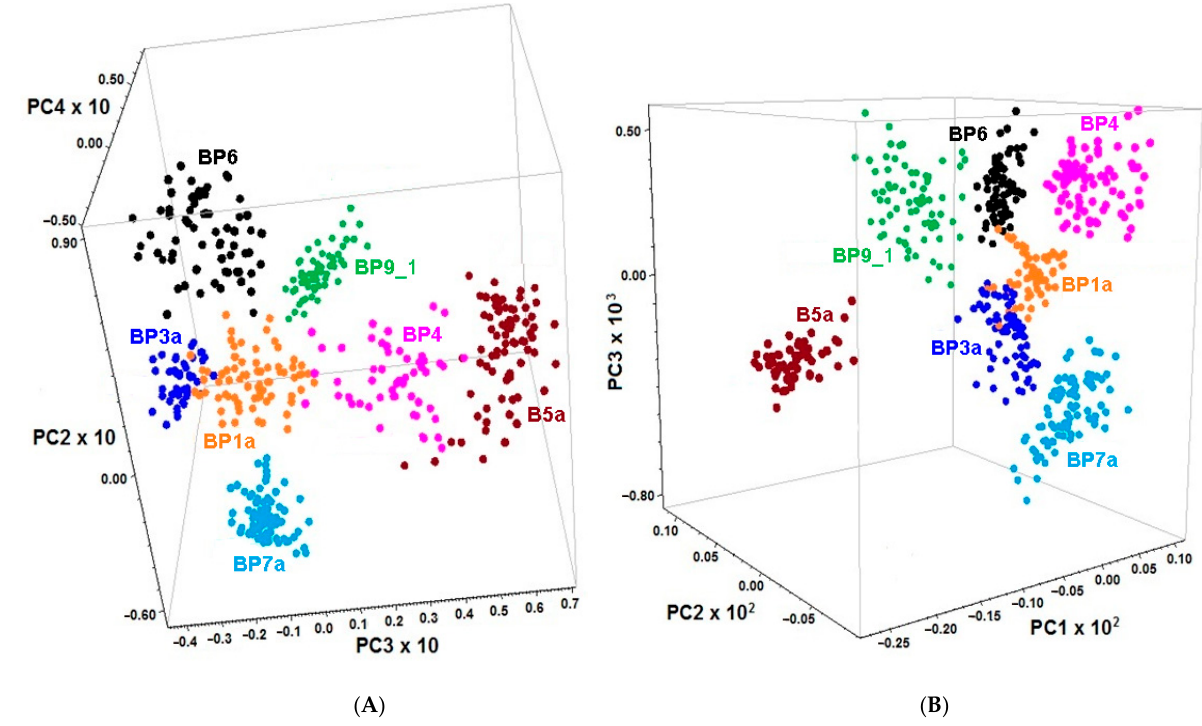
Figure 3. The 3D score graphs for PCA of the 1st derivatives of normalized FT-MIR ( A ) and FT-NIR ( B ) spectra of the loads randomly chosen from the unifloral ( BP4 , BP6 and BP9 _1) and the main fractions of polyfloral ( BP1a , BP3a , BP5a and BP7a ) bee pollens.